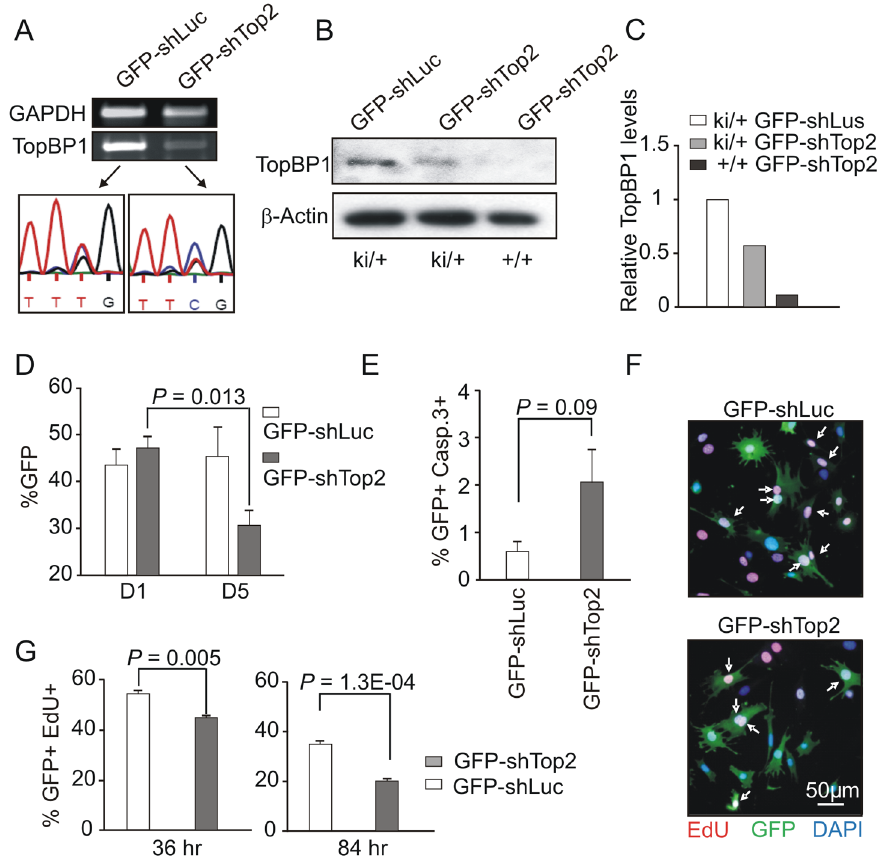
Figure 3. AAD mutation compromises cell proliferation and promotes cellular senescence. ( A ) RT-PCR and sequencing analysis of TopBP1 mRNA in sorted GFP-positive TopBP1 ki/ + cells after transfection with indicated vectors. ( B ) Immunoblot analysis of protein extracts from GFP-positive TopBP1 ki/ + or TopBP1 + / + cells 36 hr after transfection with GFP-shLuciferase (GFP-shLuc) or GFP-shTop2. ( C ) Quantification of TopBP1 in B. Average of two independent experiments. ( D ) Percentage of GFP + cells in the TopBP1 ki/ + cell population at day 1 (D1) and days 5 (D5) following shRNA transfection. Results represent 3 independent experiments for each time point. Student’s t -test was used for statistical analysis. ( E ) Quantification of cleaved caspase 3-positive cells by immunostaining 84 hr after shRNA transfection. The data represent the mean 6 SD of at least 1000 cells and two independent experiments. P value: Student’s t -test. ( F ) Representative image of TopBP1 ki/ + cells plus-labeled with EdU (red) 36 hr after transfection with GFP-shLuc or GFP-shTop2 vectors. DNA was stained with DAPI (blue). Arrows point to EdU and GFP double positive cells (EdU + GFP + ) cells. ( G ) Quantification of the percentage of Edu + GFP + in the total GFP + population at 36 hr and 84 hr after shRNA transfection. The data represent the mean 6 SD of at least 1000 cells for each group and three independent experiments. P value: Student’s t